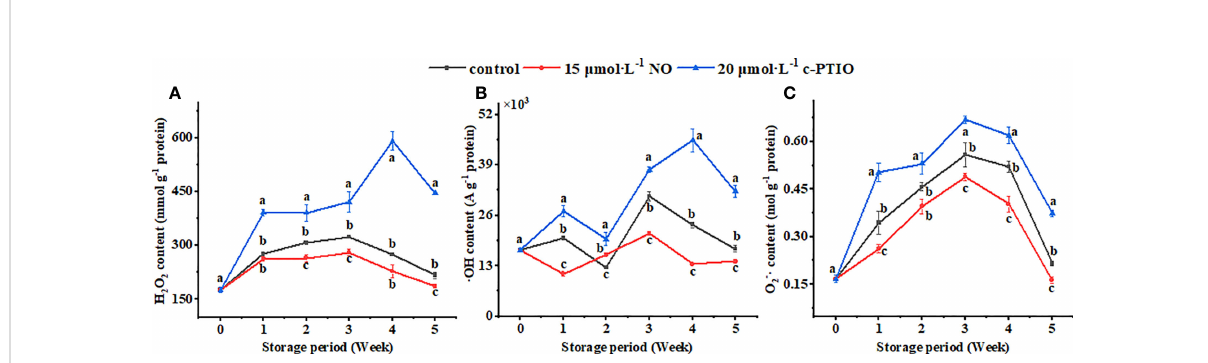
FIGURE 2 Changes in H 2 O 2 (A) , ·OH (B) , and O 2 − · (C) contents in peach mitochondria. Error bars indicate standard errors ( n = 3). Different letters indicate signi fi cant differences among different treatments ( P <